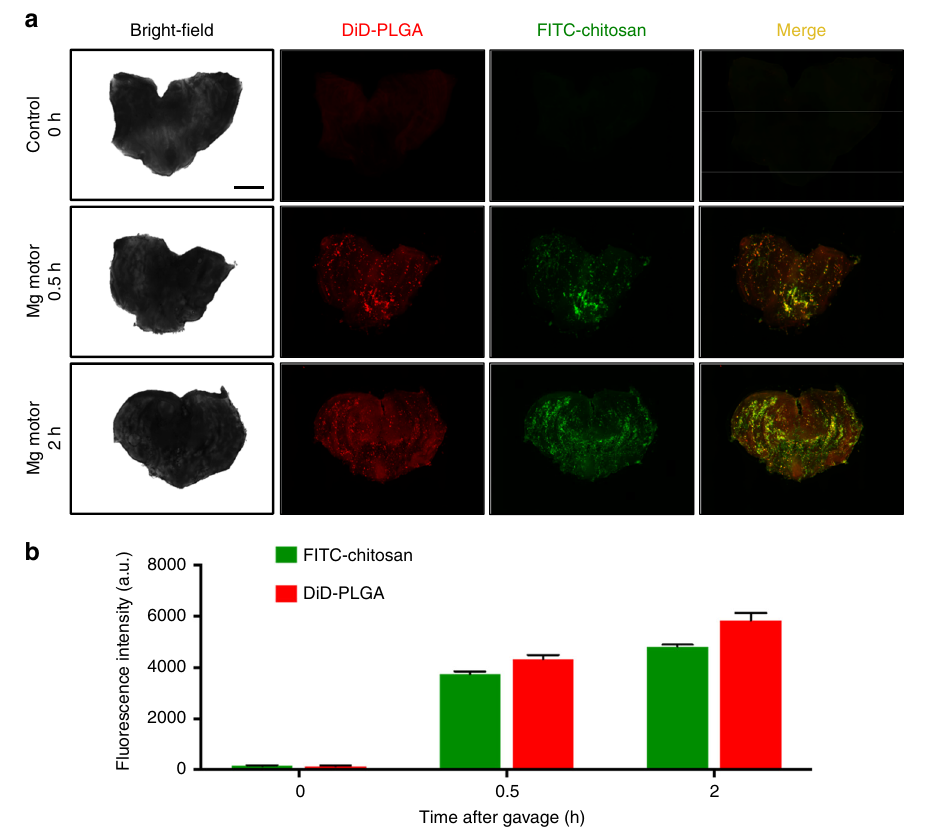
Fig. 3 Retention of the Mg-based micromotors in mouse stomachs. a Bright- fi eld and fl uorescence images of the luminal lining of freshly excised mouse stomachs at 0 min after oral gavage of deionized (DI) water (control), and at 30 min and 2 h after oral gavage of the Mg-based micromotors. Scale bar 500 mm. b Corresponding fl uorescence quanti fi cation of all the images shown in a . Error bars estimated as a triple of s.d. ( n =